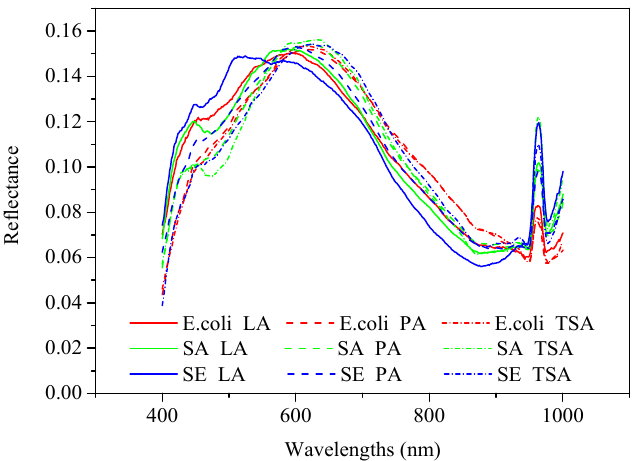
Figure 1. Spectra of bacterial colonies. Note: E. coli, SA and SE are abbreviations of Escherichia coli , Staphylococcus aureus and Salmonella , respectively; LA, PA and TSA are abbreviations of Luria–Bertani agar, plate counting agar and tryptone soy agar, respectively. For example, E. coli LA represents the Escherichia coli cultured on Luria–Bertani agar.